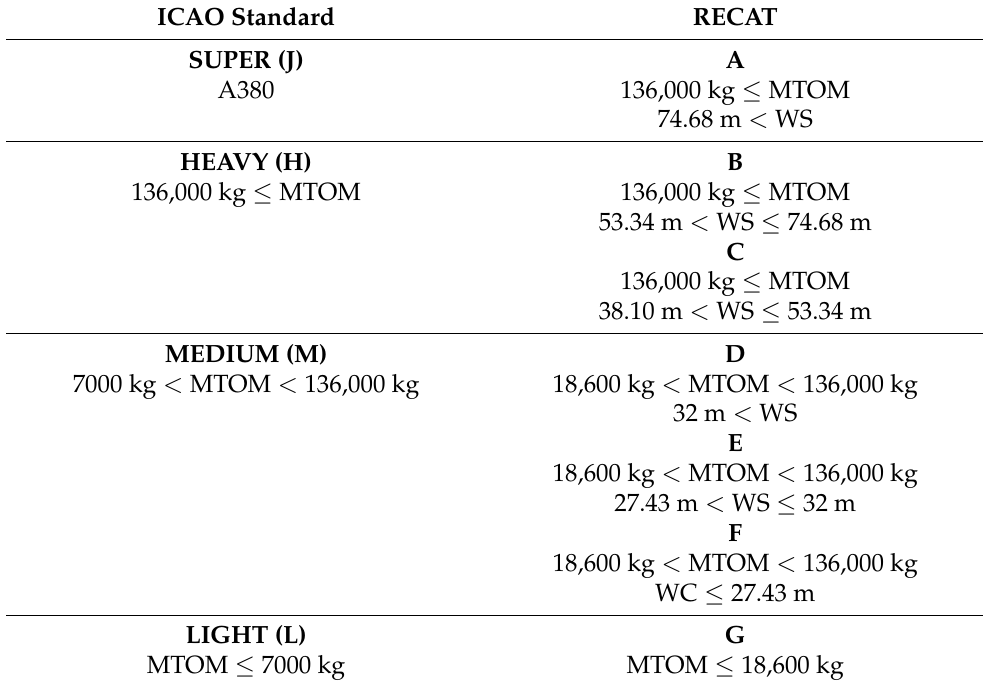
Table 1. Comparison of wake turbulence category.